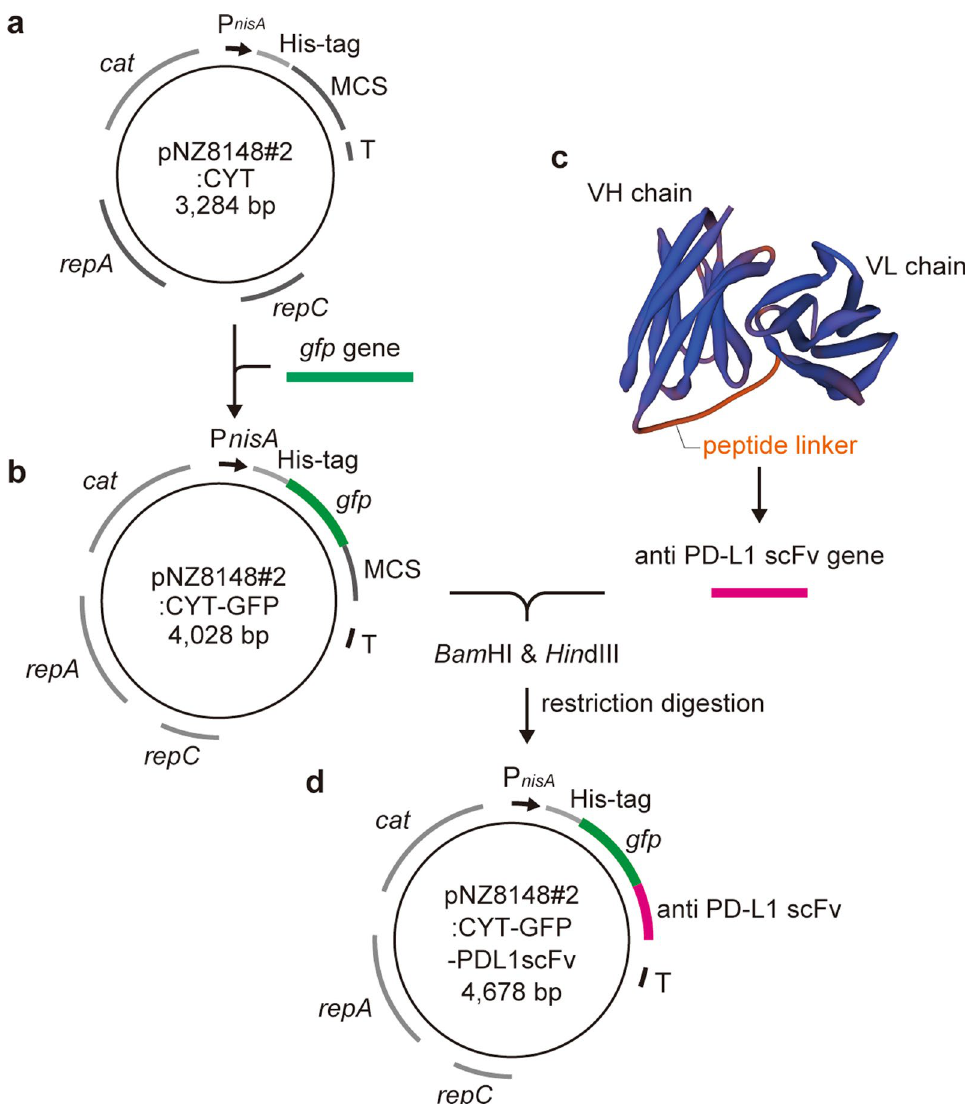
Fig. 1 Scheme of plasmid construction. a The lactococcal gene expression vector, pNZ8148#2:CYT, derived from commercially available pNZ8148. b The green fluorescent protein (GFP) gene was integrated into pNZ8148#2:CYTo construct the lactococcal GFP expression vector, pNZ8148#2:CYT-GFP. c Predicted 3D model of PDL1scFv designed using SWISS-MODEL. The locations of the VH chain, VL chain, and peptide linker (EGKSSGSGSESKS) are shown. VH chain; variable region of the heavy chain, VL chain; variable region of the light chain. d The PDL1scFv gene was integrated into pNZ8148#2:CYT-GFP by restriction digestion using Bam HI and Hin dIII to construct GFP-conjugated PDL1scFv expression vector, pNZ8148#2:CYT-GFP-PDL1scFv. P nisA : nisin-inducible promoter, His-tag six-histidine tag, MCS multiple cloning site, T terminator, repC and repA origins of replication, Cat chloramphenicol acetyltransferase, GFP green fluorescent